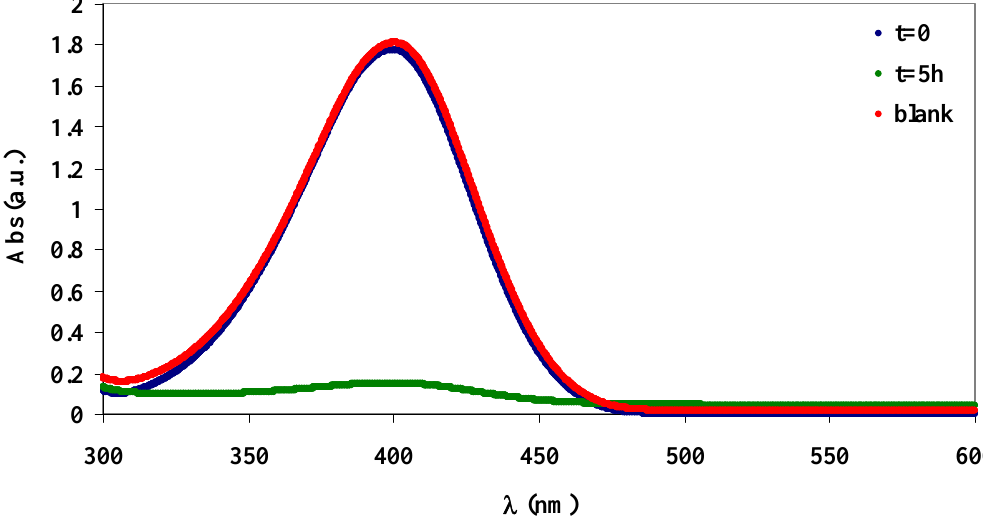
Figure 9. UV-Vis spectra of NP aqueous solutions. Blue : [NP] = 1 × 10 − 4 M before the addition of cellulose. Green : 5 h after the addition of I . Red : 5 h after the addition of α -cellulose D